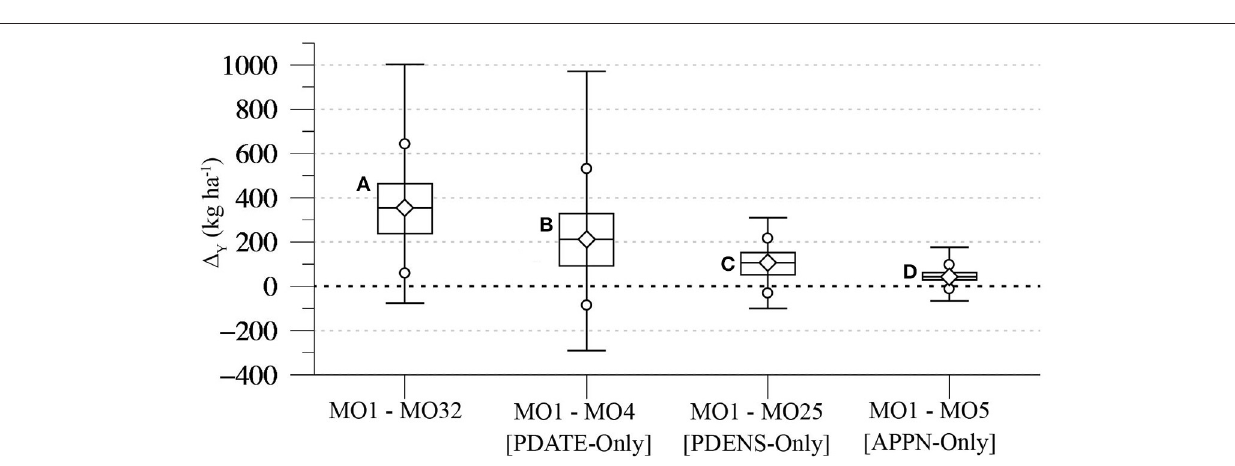
Figure 6B graphs lint yields from 2017 field trials conducted at the USDA-ARS Plant Stress and Water Conservation Laboratory in Lubbock (hereafter PSWCL17), which included replications at four irrigation levels, each repeated at 6 planting dates between